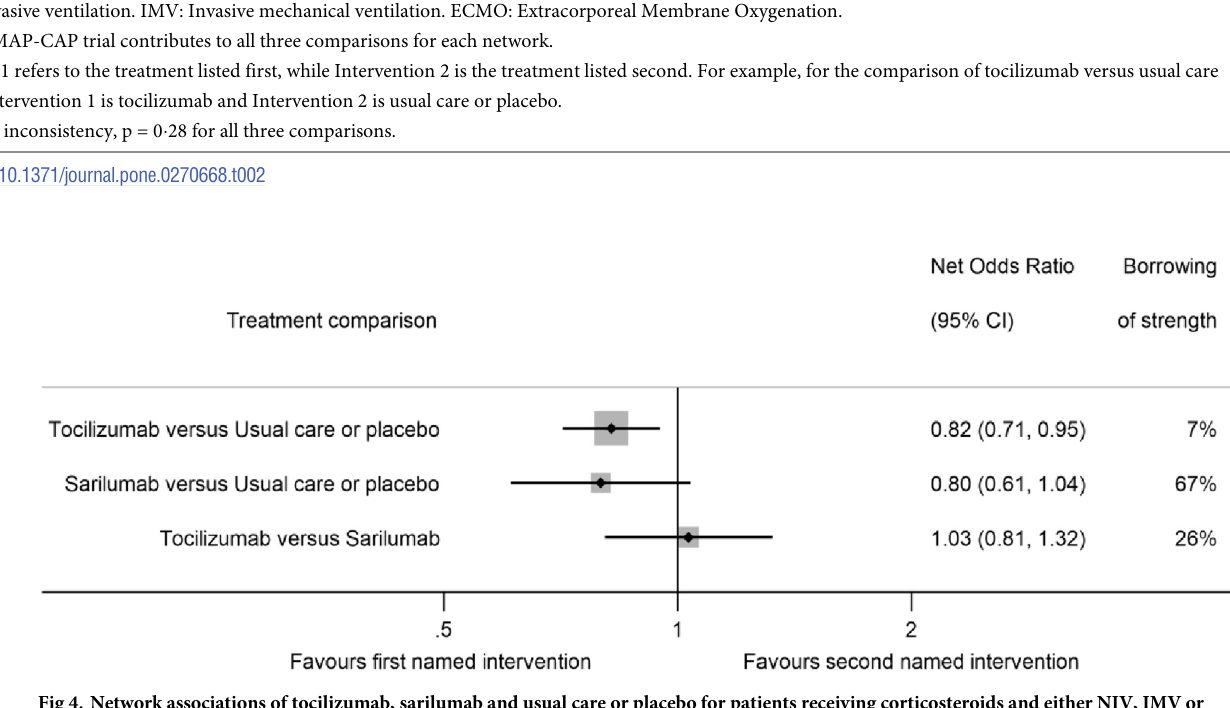
Fig 4. Network associations of tocilizumab, sarilumab and usual care or placebo for patients receiving corticosteroids and either NIV, IMV or ECMO at randomisation with all-cause mortality 28 days after randomisation. NIV: Non-invasive ventilation. IMV: Invasive mechanical ventilation. ECMO: Extracorporeal Membrane Oxygenation. Size of markers is proportional to the inverse of the variance from the net estimate. Borrowing of strength illustrates the proportion of information for each net odds ratio that is due to indirect evidence.